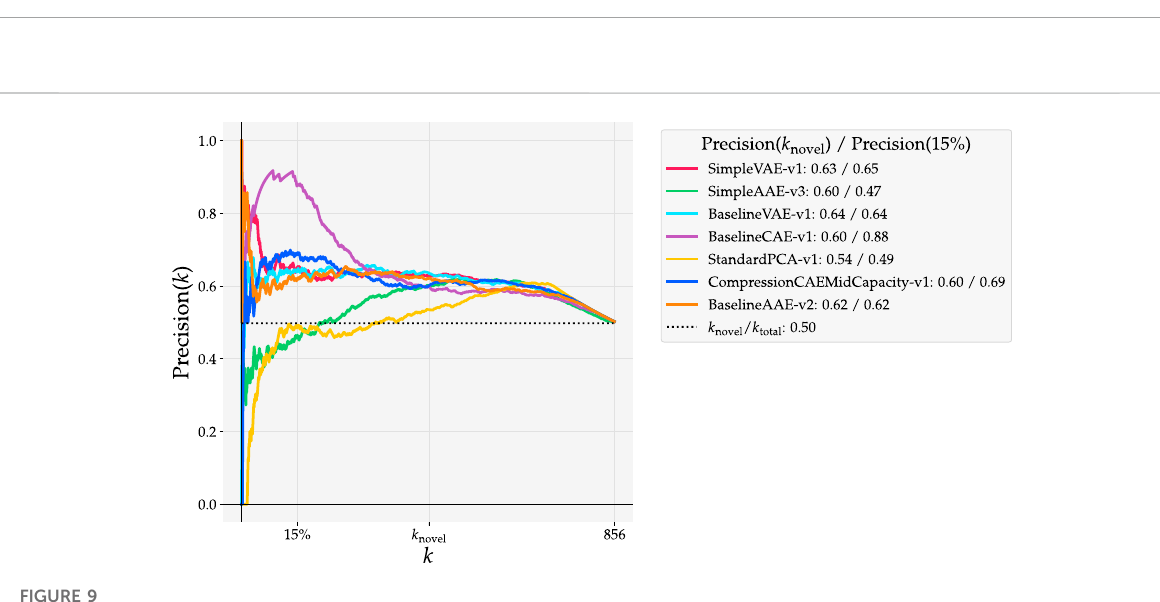
FIGURE 8 ROC curves for reconstruction-based detections with models trained on Curiosity Mastcam. At the point marked ■ the BASELINECAE obtains an (cid:129) the PCA model hits full recall earlier than any of the other models. LR+ = 7.85. At the point marked